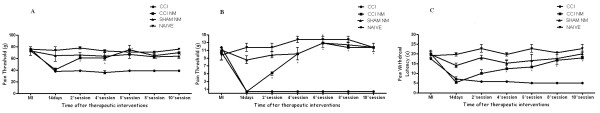
 Effect of neural mobilization on pain threshold induced by CCI in rats. Pain thresholds as measured by the test of Randall & Selitto (A), von frey test (B), expressed in grams, and thermal hyperalgesia, assessed by Hargreaves test (C), expressed in seconds. Measurements were determined before (base line- BL), 14 days after and at different intervals after NM sessions. The results represent the mean ± SEM of 10 animals per group. * P <0.05 for comparison between groups: CCI and CCI NM.